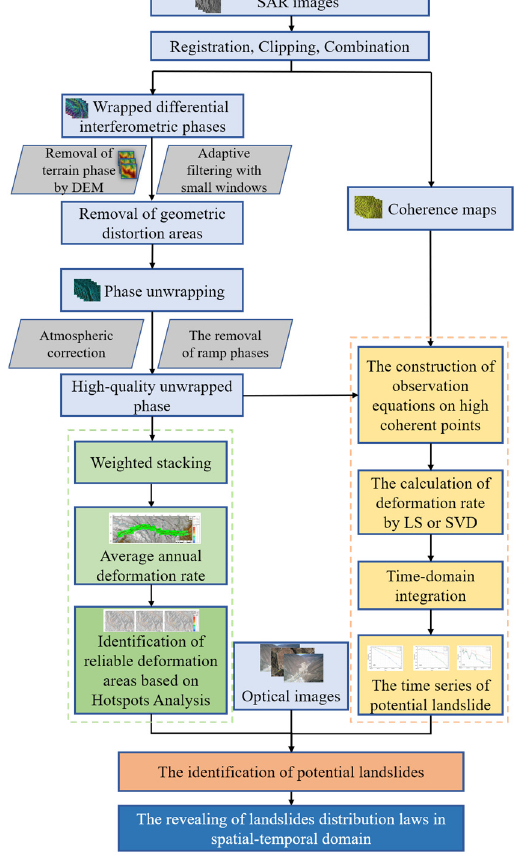
Figure 4. Flowchart for landslide identification and analysis.